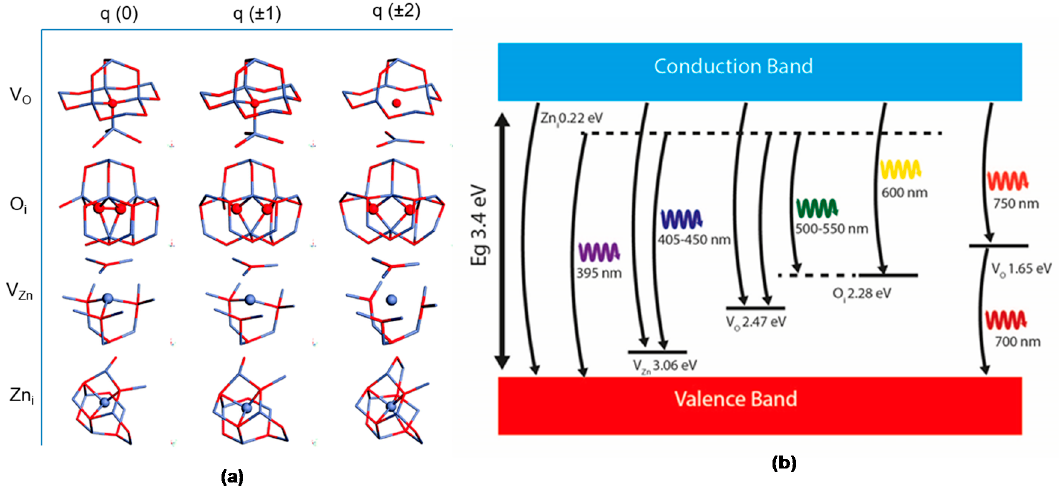
Figure 6. ( a ) Illustration of different intrinsic point defects in the ZnO lattice. Oxygen vacancy ( V O ), zinc vacancy ( V Zn ), oxygen interstitial ( O i ), and zinc interstitial (Zn i ) in different charge configurations are presented [125]. Copyright 2006 Royal Society of Chemistry ( b ) Schematic band diagram of the DLE emissions in ZnO based on the full-potential linear mu ffi n-tin orbital method and the reported data as described in references [126–135]. Also, oxygen vacancies situated 1.65 eV below the conduction band are denoted to contribute to the red emission